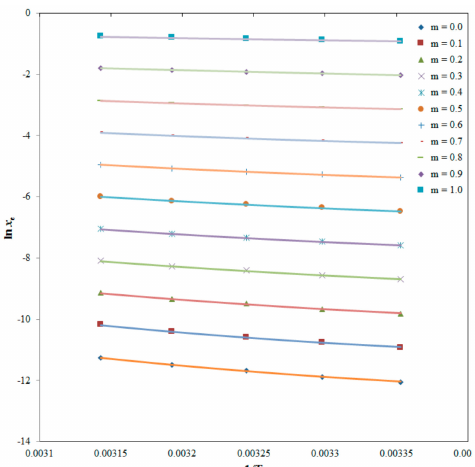
Figure 4. Correlation of ln x e values of PPD with the Apelblat model in binary DMSO + water mixtures at T = 298.2 K to 318.2 K (Apelblat solubilities are represented by solid lines and experimental solubilities of PPD are represented by